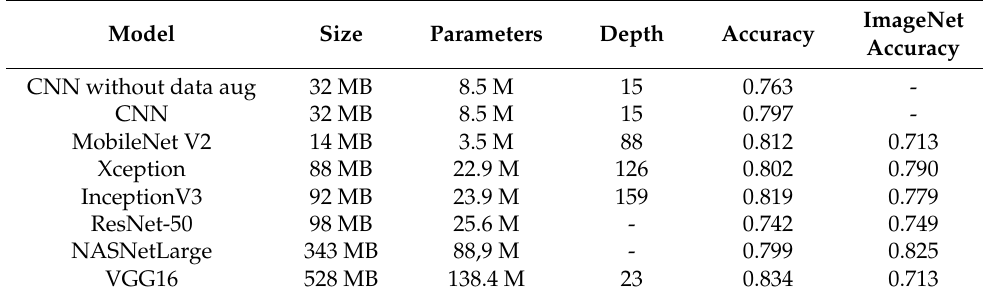
ImageNet Accuracy